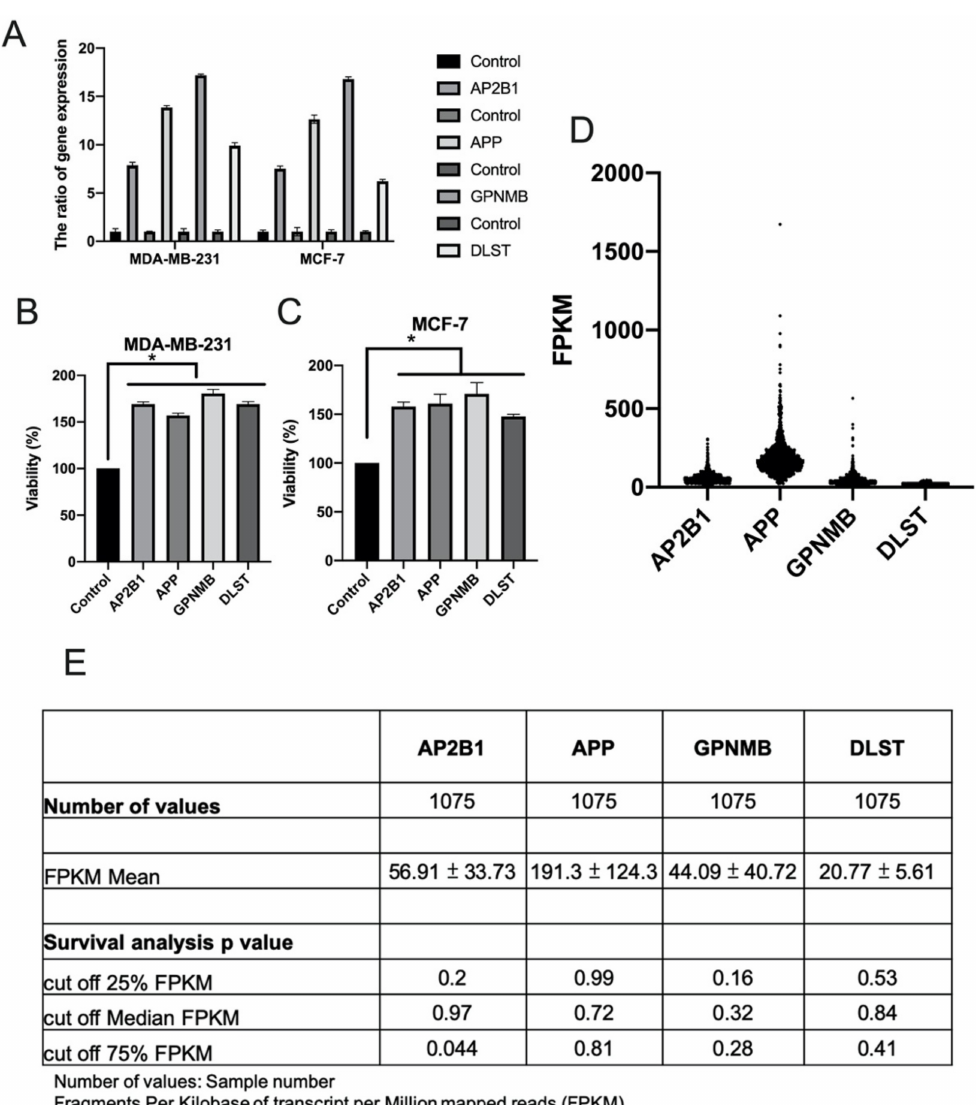
Figure 5. Role of AP2B1, APP, GPNMB and DLST in cell viability and survival. A total of 1 µ g target gene plasmid was used for the transfection of MDA-MB-231 and MCF-7 breast cancer cell lines. ( A ) Gene expression was analyzed using reverse transcription-quantitative PCR, and ( B , C ) cell proliferation was analyzed using CCK-8 assay. Data are the mean ± SD from three in- dependent experiments. * p < 0.05 vs. untreated control (data were analyzed using a two-tailed Student’s t -test). ( D , E ) Gene expression and survival rate were analyzed by fragments per kilobase per million of AP2B1, APP, GPNMB and DLST through the human protein atlas database. AP2B1, adaptor-related protein complex 2 subunit beta 1; APP, amyloid beta precursor protein; GPNMB, glycoprotein Nmb; DLST, dihydrolipoamide S-succinyltransferase. The data suggested that the four genes, AP2B1, APP, GPNMB and DLST, were highly expressed in breast cancer and that AP2B1 was a suitable prognostic marker for breast cancer. The pathway network of these candidate genes mediating the response to luteolin is illustrated schematically in Figure